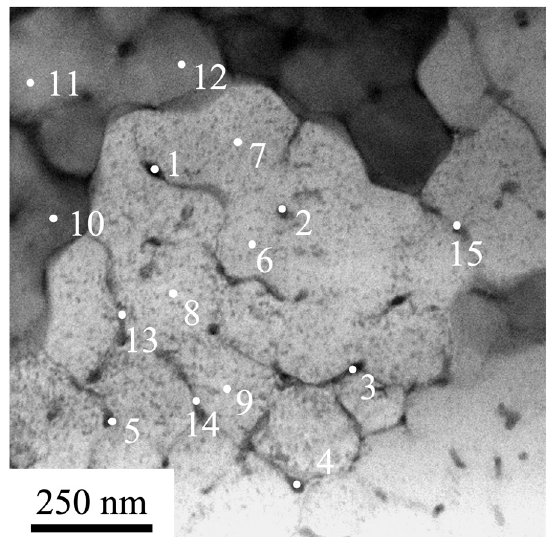
Figure 10. SEM image of a HEA irradiated by HCPEB 20 J/cm 2 , 50 µs, 3 pulses, 0.3 s –1 . The numbers indicate areas where EDS analysis was carried out.